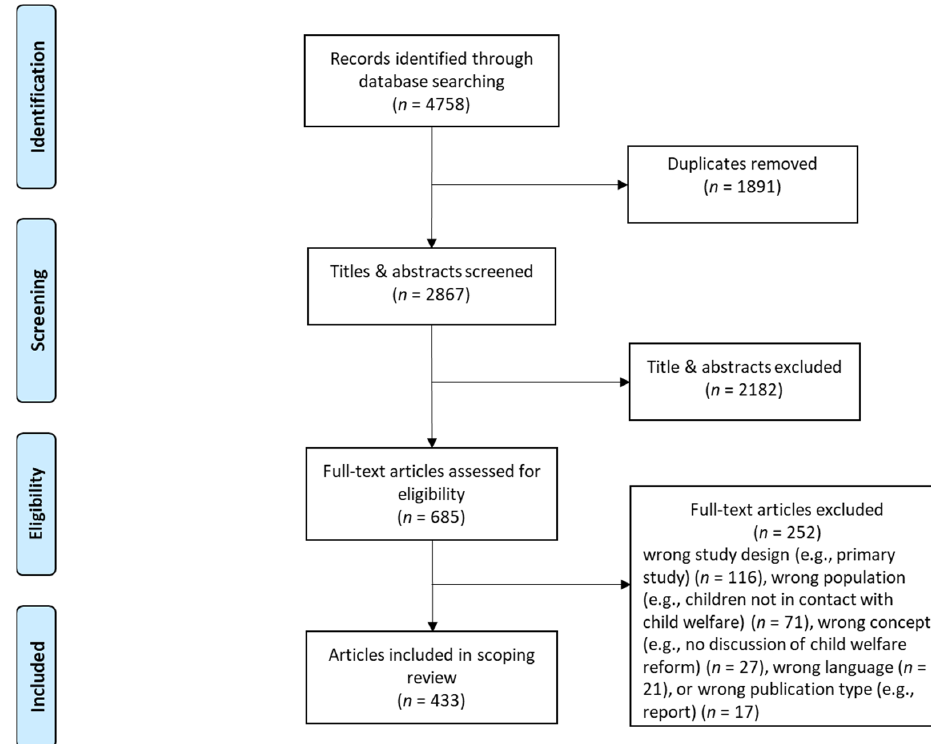
Figure 1. PRISMA flow diagram.